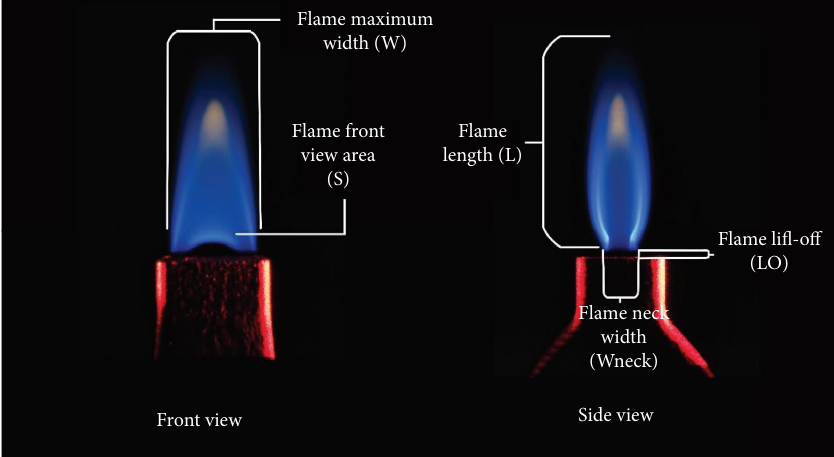
Figure 10: Defnitions of fame characteristics.